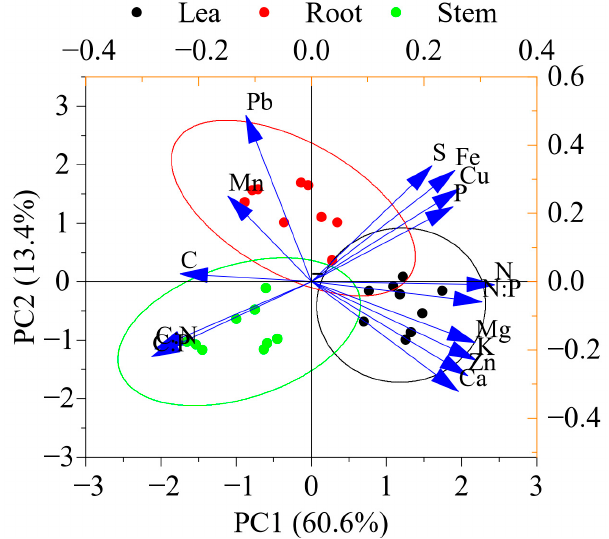
Figure 5. Principal component analysis of ion contents and stoichiometric pattern in different organs of R. chinensis . Clusters of the organs (ellipses significance = 0.95). The lines originating from central point of biplots indicate positive or negative correlations of different variables.